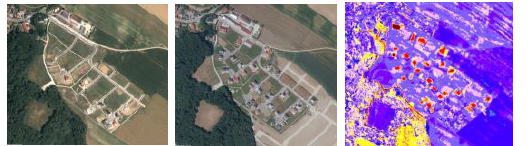
Figure 6. Differential DSM between LiDAR and Image Matching – new buildings are painted in red and areas under construction in violet